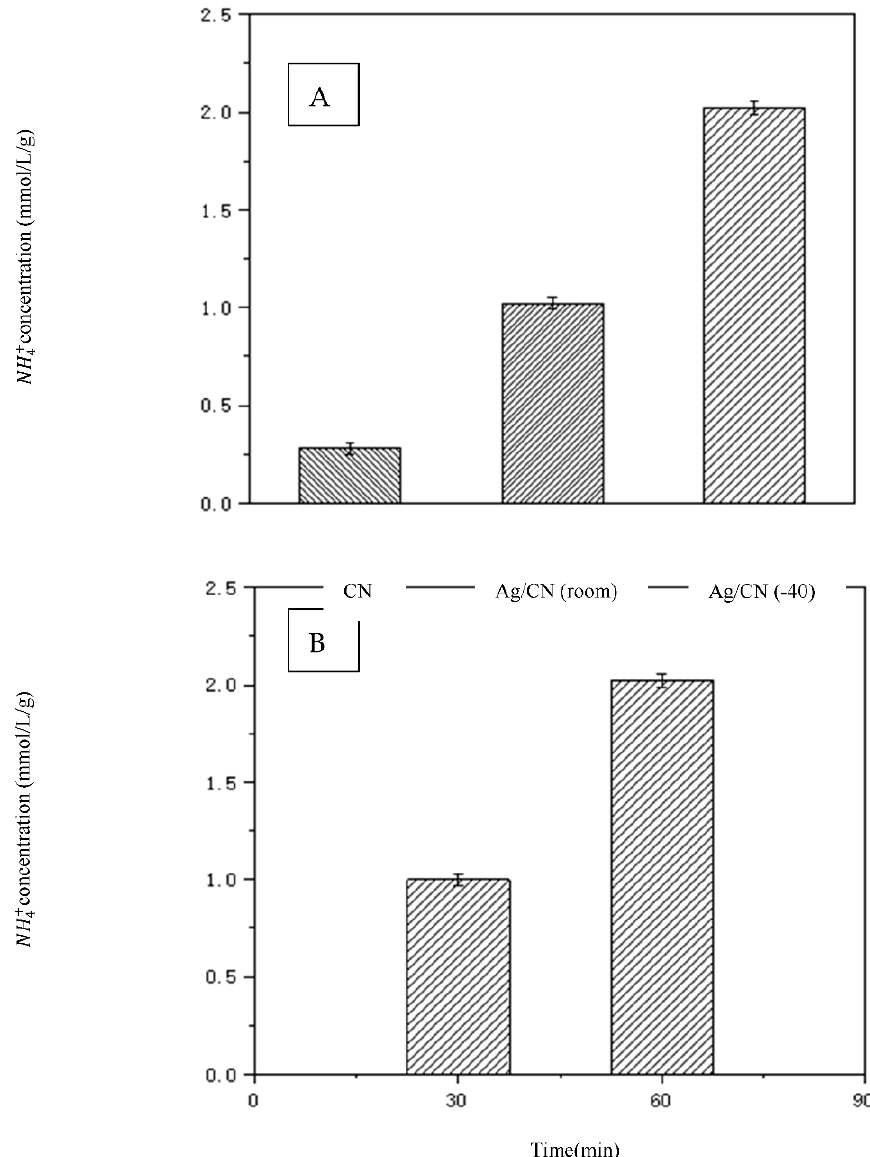
Figure 5. ( A ) N 2 fixation rate in 1 h. ( B ) N 2 fixation rate of Ag/CN ( − 40) at different times. The error bars are according to the test error of Nessler’s reagent spectrophotometer method.